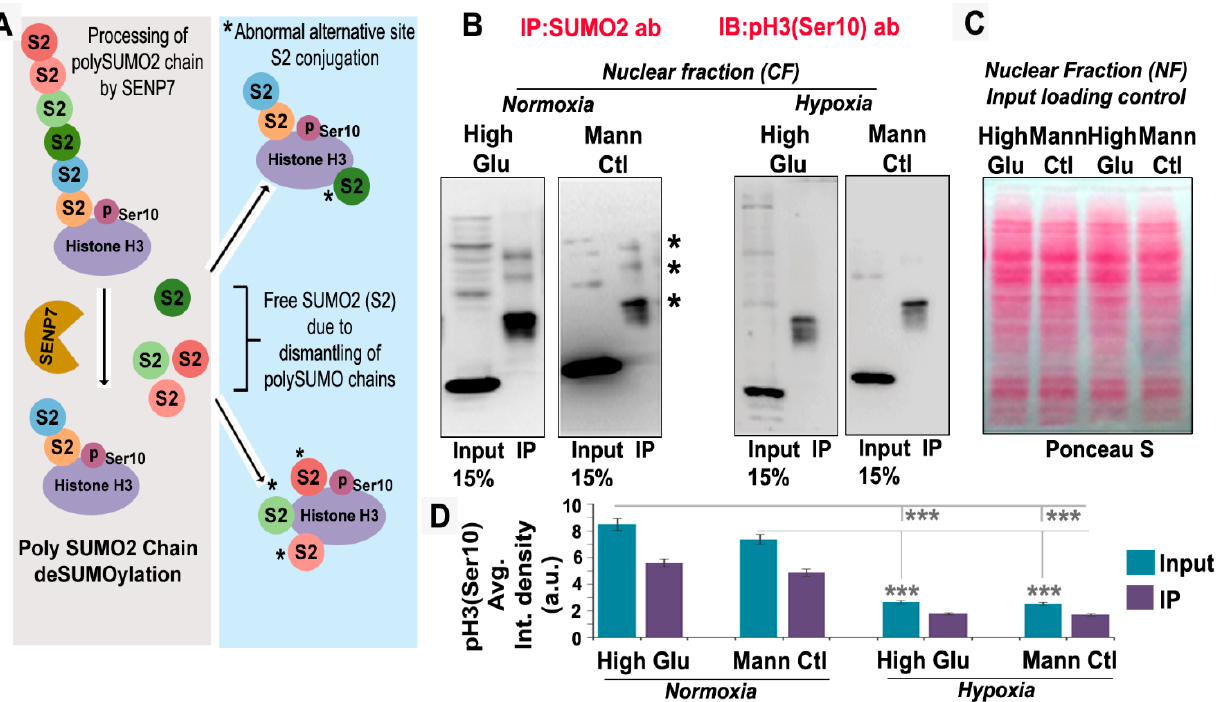
Figure 11. Acute hypoxia promotes abnormal SUMOylation of pH3(Ser10), likely through SENP7. ( A ) SENP7 is specific to the SUMO2 substrate, and its polySUMO2 chain shortening and deSUMOylation activity can generate free SUMO2 residues that can then bind to alternative abnormal sites in the same protein. Either way, SUMO2 chain shortening or abnormal multisite SUMOylation can compromise pH3(Ser10) solubility, nuclear trafficking and functions. ( B ) Tumour cells were subjected to the basic treatment conditions for 96 h. Nuclear lysates were prepared through subcellular fractionation and immunoprecipitated (IP) with SUMO2 antibody. The IP samples were immunoblotted for pH3(Ser10). Data unveiled that there was a loss of higher molecular weight pH3(Ser10) bands in hypoxia (see asterisks), and the levels of pH3(Ser10) by itself were less in input and IP samples in comparison to normoxic conditions. ( C ) Ponceau S staining of the IP samples showed equal loading. Further, input from the hypoxia sample showed lower molecular weight bands not identified in the normoxia sample. This suggests that SUMOylated pH3(Ser10) that managed to enter the nuclei of hypoxic tumour cells was differentially modified by SUMO2 vs normoxia counterparts. ( D ) Nuclear levels of total pH3Ser(10) in the input and SUMOylated pH3(Ser10) in the IPed samples were quantitated in HG and HG-HO conditions under normoxia and hypoxia. Data were represented as Average Integrated Density. Data show that in hypoxic HG and HG-HO conditions, total and SUMOylated pH3(Ser10) were significantly less compared to normoxic conditions. Statistical significance is represented by p values: * p ≤ 0.05, ** p ≤ 0.01 and *** p ≤ 0.001.